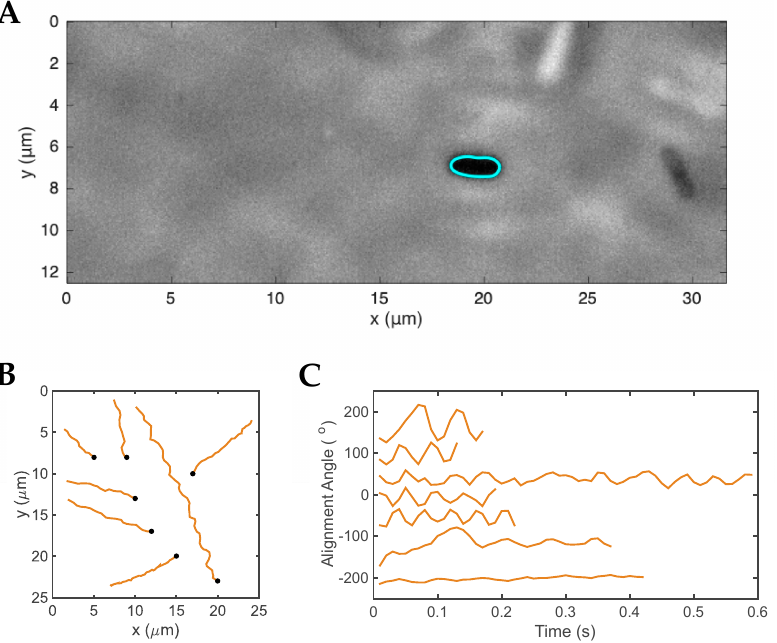
Figure 4. Swimming of H. cetorum in culture broth BB10. ( A ) A single frame from the movie shows several bacteria and the contour outlining one of them. ( B ) Trajectories of individual runs. The trajectories were randomly distributed over the figure for better visualization and do not depict the real position in the movie. ( C ) Time-dependent variation of the alignment angle of the center axis of the body relative to the x -axis (arbitrarily defined in the movie). The alignment angle values were shifted along the y -axis for better visualization. Adapted from Constantino [59].